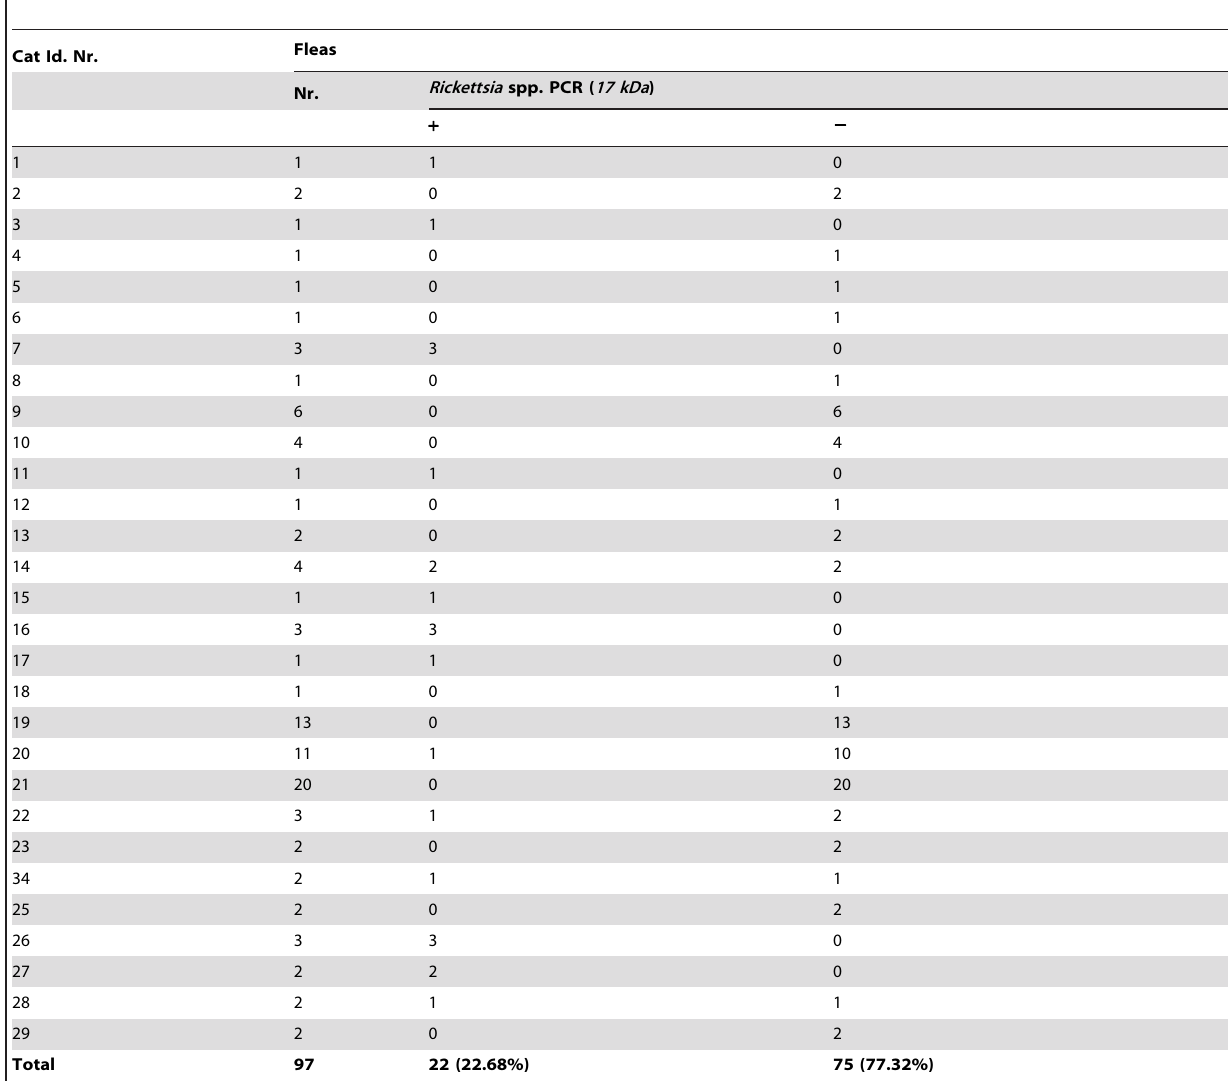
Table 2. Flea distribution on cats ( 1 owned cat), with the results of Rickettsia spp. PCR performed on 97 fleas.